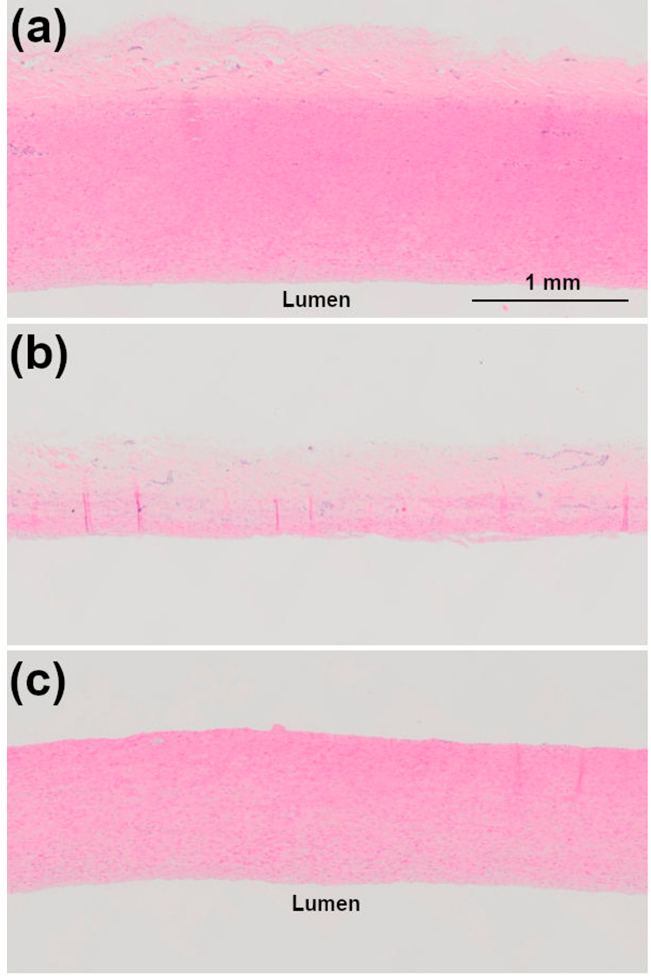
Figure 2. Gross histology of porcine abdominal aorta: ( a ) aortic wall; ( b ) isolated adventitia; ( c ) the remaining layers. H&E staining.